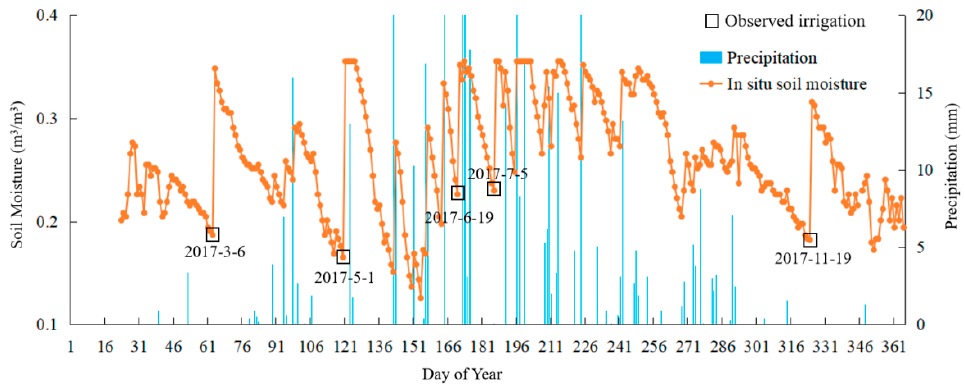
Figure 3. In situ soil moisture, precipitation, and observed irrigation records at the 53992 station for